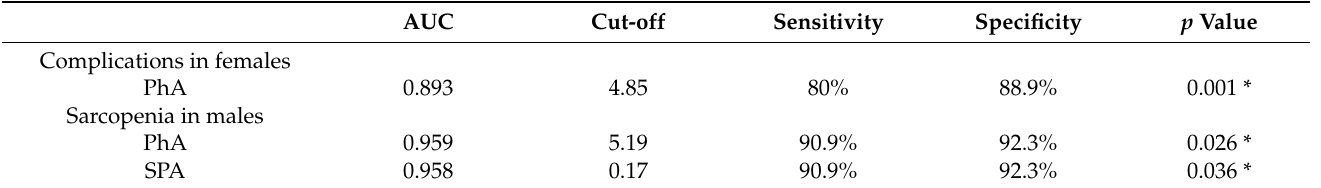
Figure 2. A principal component analysis using reactance and resistance as variables for the comparison between patients with complications and those without complications ( A ), and between patients with sarcopenia and those without sarcopenia ( B ). Table 4. Predictive value of phase angle on complications and sarcopenia in colorectal cancer patients.